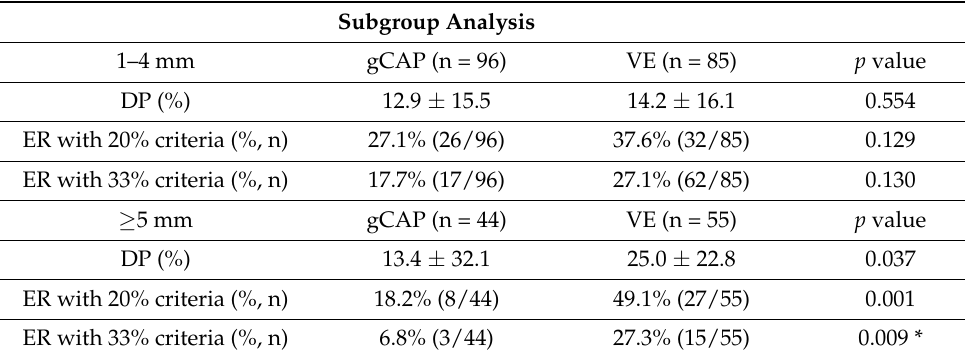
Table 3. Subgroup analysis according to polyp size.